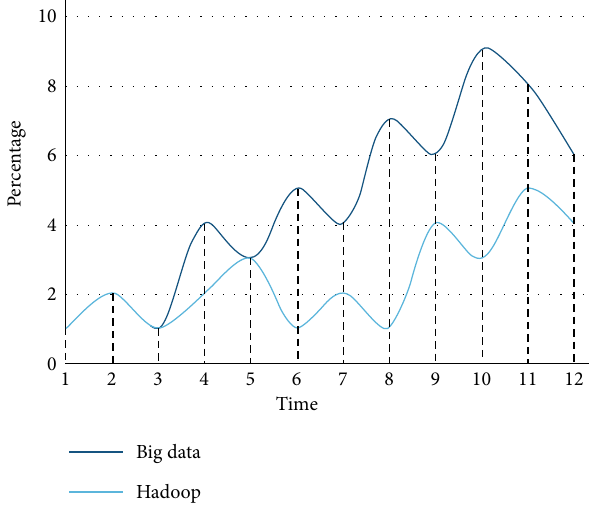
Figure 2: Search trend comparison score.